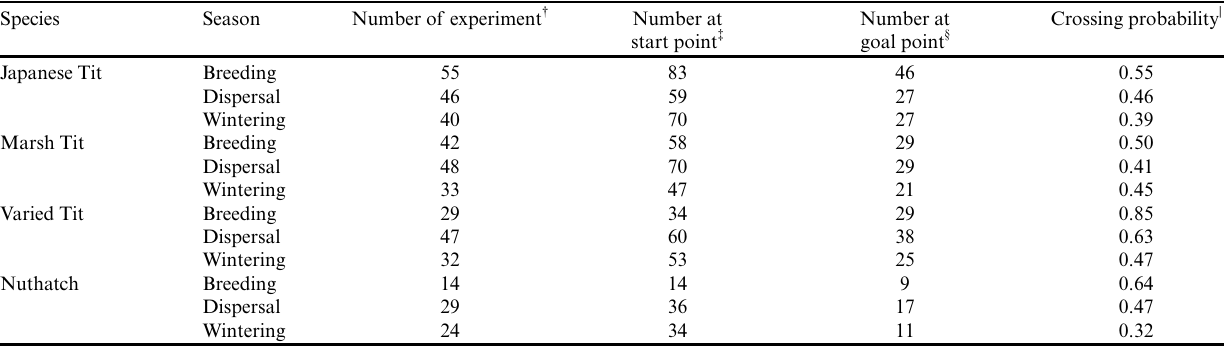
Number at Crossing probability | start point ‡ goal point §